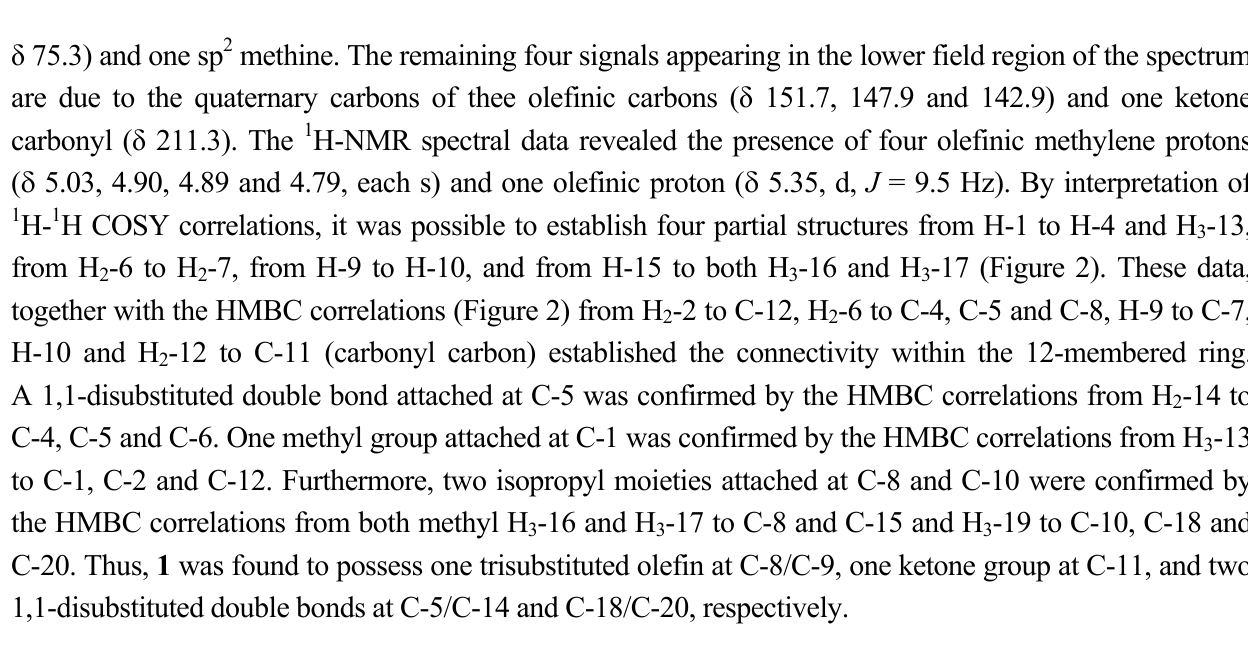
Table 1. 1 H and 13 C-NMR data for 1